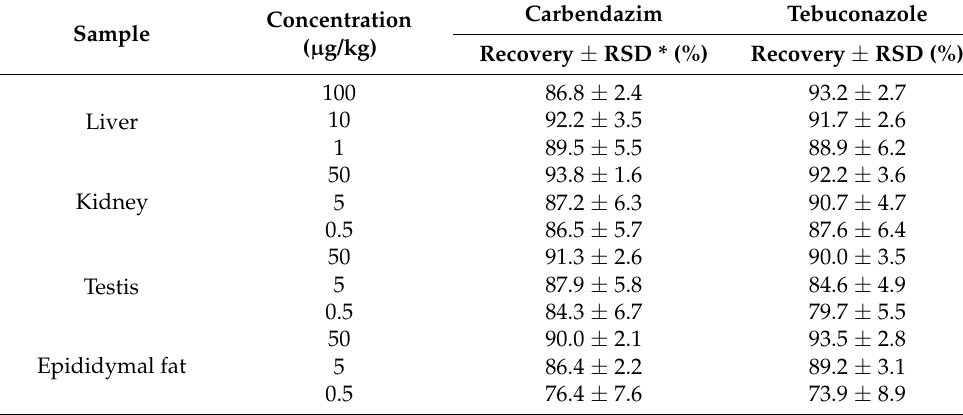
Table 2. Average recovery precision of carbendazim and tebuconazole in the samples.